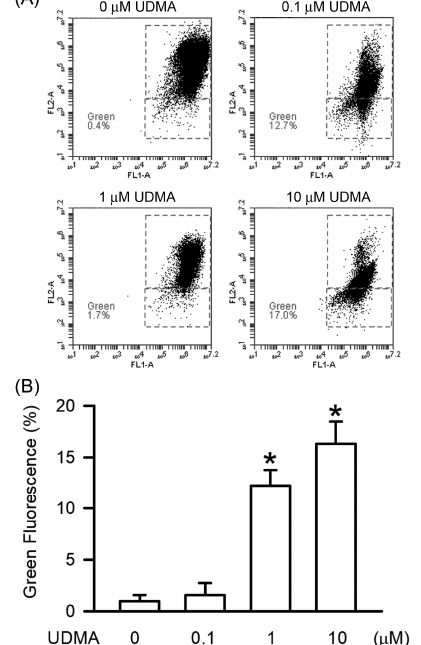
Figure 6. UDMA induced mitochondrial dysfunction in RAW264.7 macrophages. ( A ) Cells were incubated with UDMA at concentrations of 0, 1, 10, and 100 μ M for 24 h at 37 °C. The portion of mitochondria dysfunction was measured using the JC1 assay. ( B ) Quantitatively, the percentage of cells with mitochondrial dysfunction were calculated and analyzed. Data are expressed as mean ± SD (n = 5). *P < 0.05 is considered significant compared with control group.